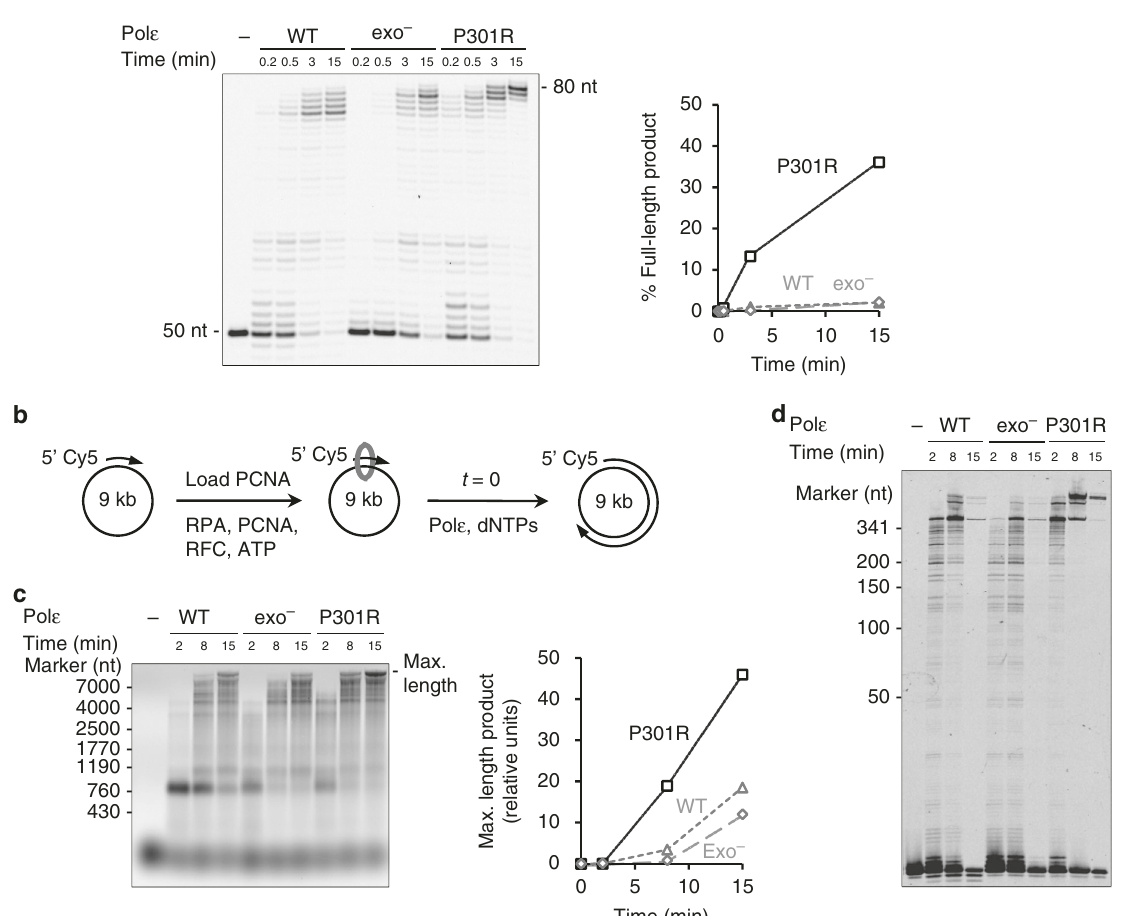
Fig. 3 Pol ε -P301R has a robust DNA polymerase activity superior to that of the wild-type or proofreading-de fi cient Pol ε . a DNA polymerase activity was assayed using 25 nM correctly matched P50/T80a oligonucleotide substrate (shown above the gel image) and 6.25 nM polymerase, and the fraction of full-length product (80 nt) was quanti fi ed. Representative of two independent experiments. b Schematic of DNA replication assay on the circular M13/ CAN1(1-1560-F) substrate. c M13/CAN1(1-1560-F) replication reactions were performed at a Pol ε :substrate ratio of 5:1. The products were separated in a 0.8% alkaline agarose gel, and the fraction of maximal-length products was quanti fi ed. Representative of two independent experiments. d The